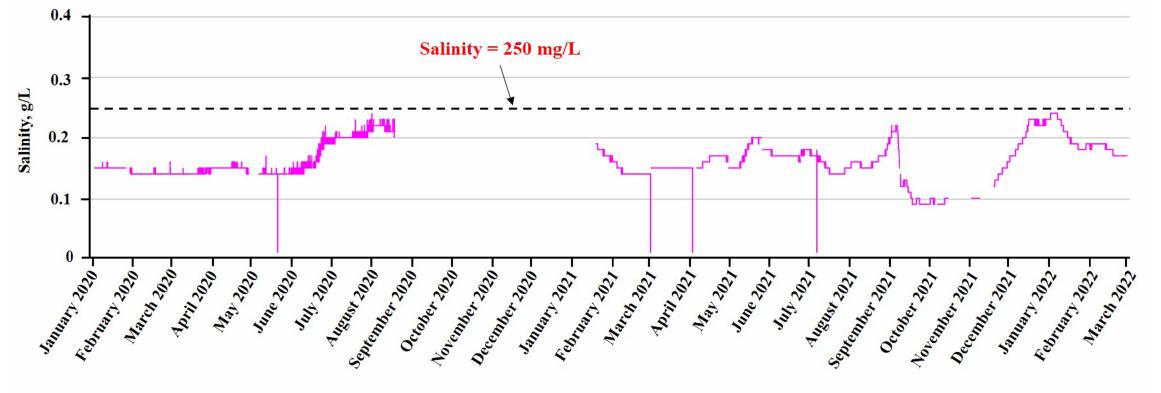
Fig. 6. Daily monitored salinity in Chao Phraya River at Wat Pho Taeng Nuea water monitoring station (2020-2022). (Source: